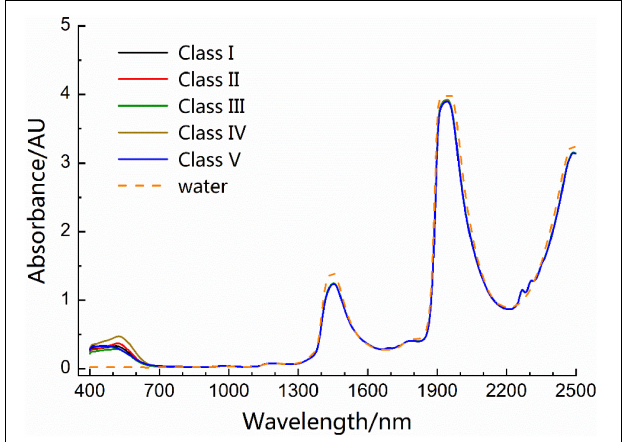
FIGURE 2 | Average spectra of five types of wine and the spectrum of distilled water in the visible and near-infrared (Vis-NIR)